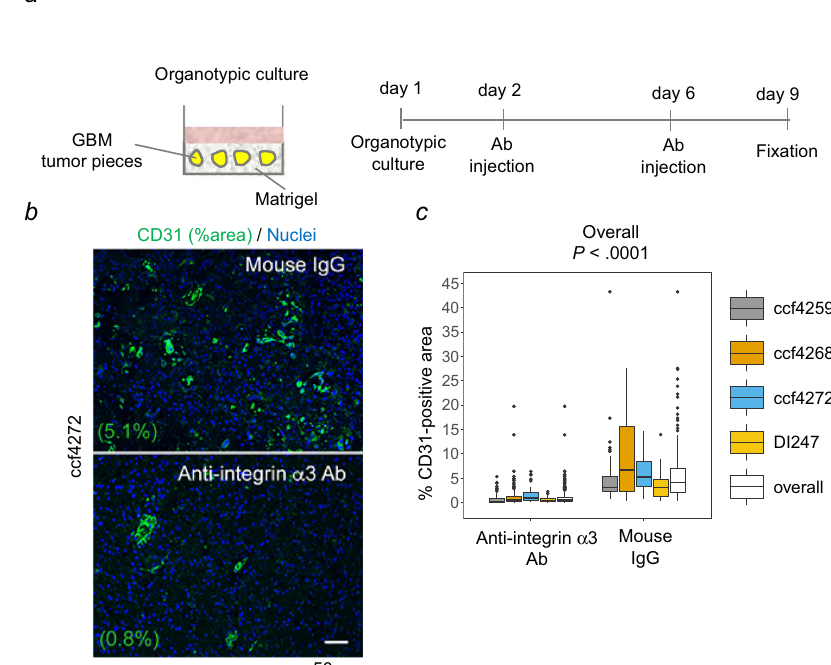
Fig. 4 A function blocking antibody directed towards integrin α 3 β 1 reduces blood vessel density in GBM tumors in organotypic culture. a Schematic diagram of the experimental procedure. Brie fl y, GBM tumors (ccf4259, ccf4268, ccf4272, and DI247) cut into ~4mm in diameter were cultured in Matrigel in neurobasal medium supplemented with 1ng/ml EGF and 1ng/ml bFGF. On day 2, anti-integrin α 3 subunit blocking antibody or control mouse IgG was